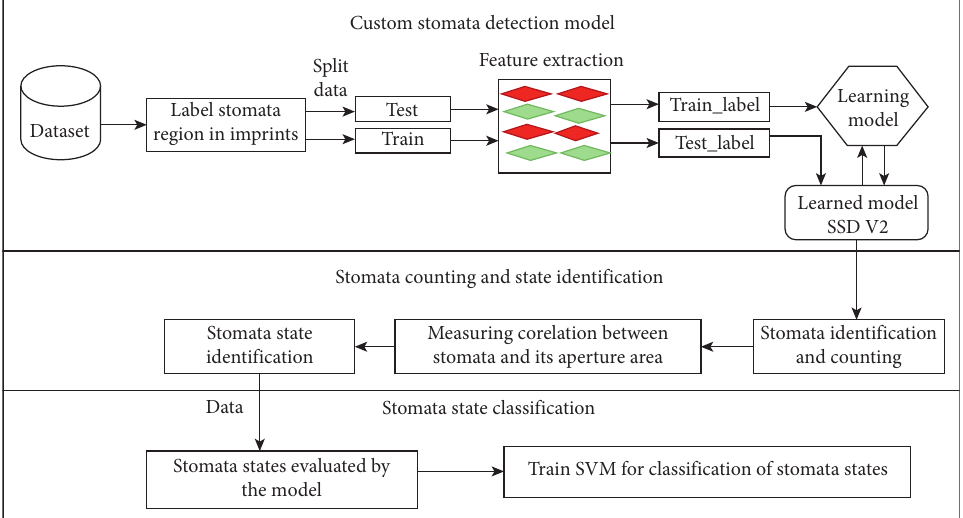
Figure 2: Methodology of the proposed